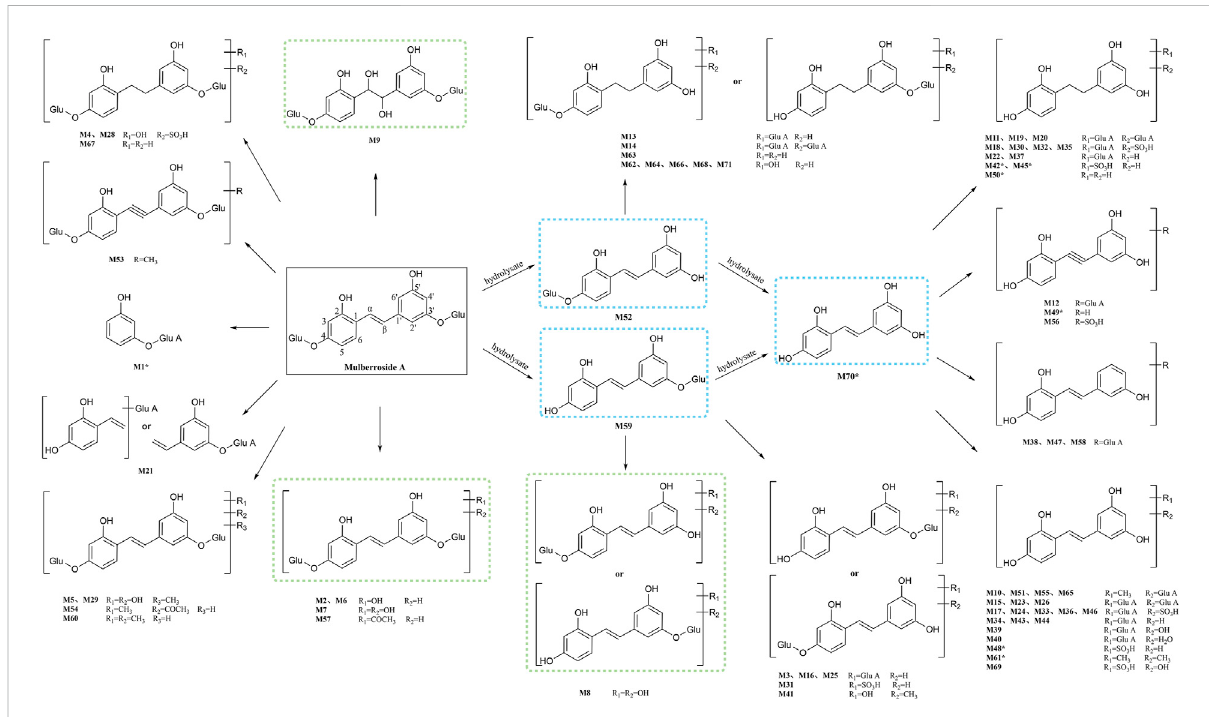
FIGURE 7 The proposed metabolic pathways of mulberroside A in vivo and in vitro of rats. Note: Glu: glucose; Glu A: glucuronic acid; component with blue fl ame: metabolite in vivo and in vitro ; component with green fl ame: metabolite in vitro ; *: components in Table